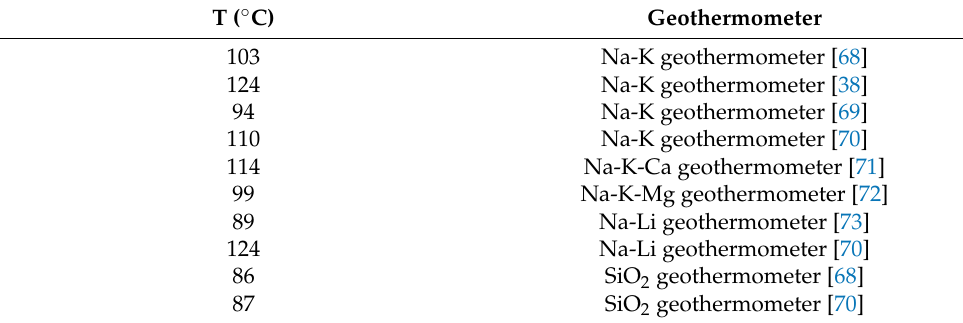
Table 3. Deep reservoir temperatures estimated by aqueous geothermometers ( ◦ C).